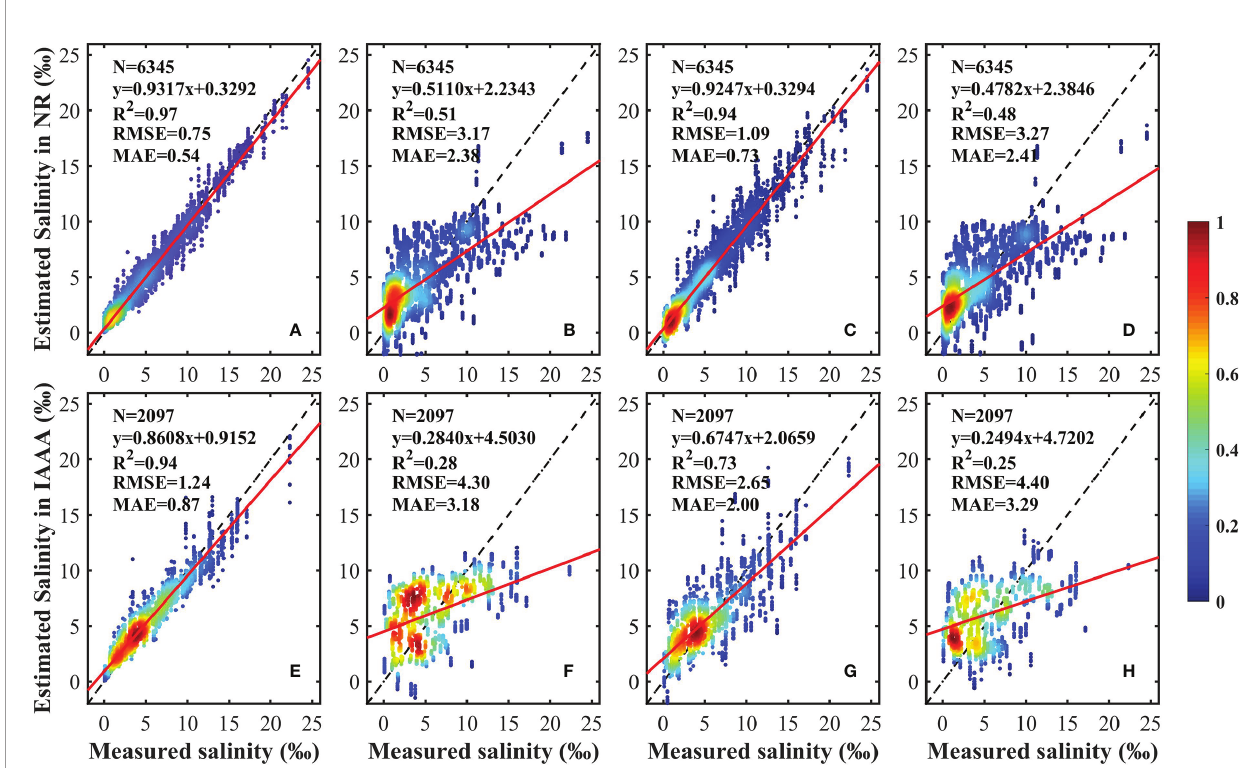
FIGURE 4 | Scatterplots of the model fi tting results of the random forest model (A, E) , the multiple linear regression model (B, F) , the geographically weighted regression model (C, G) , and the partial least squares regression model (D, H) . The color represents the density of the point. The black dashed and red solid lines represent the 1:1 line and the linear regression line,